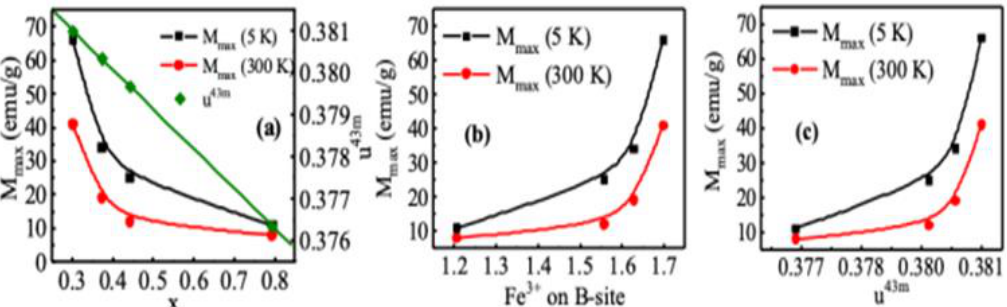
Figure 6. Maximum magnetization with ( a ) inversion parameter, ( b ) with cation distribution in the octahedral site, and ( c ) with oxygen parameter.